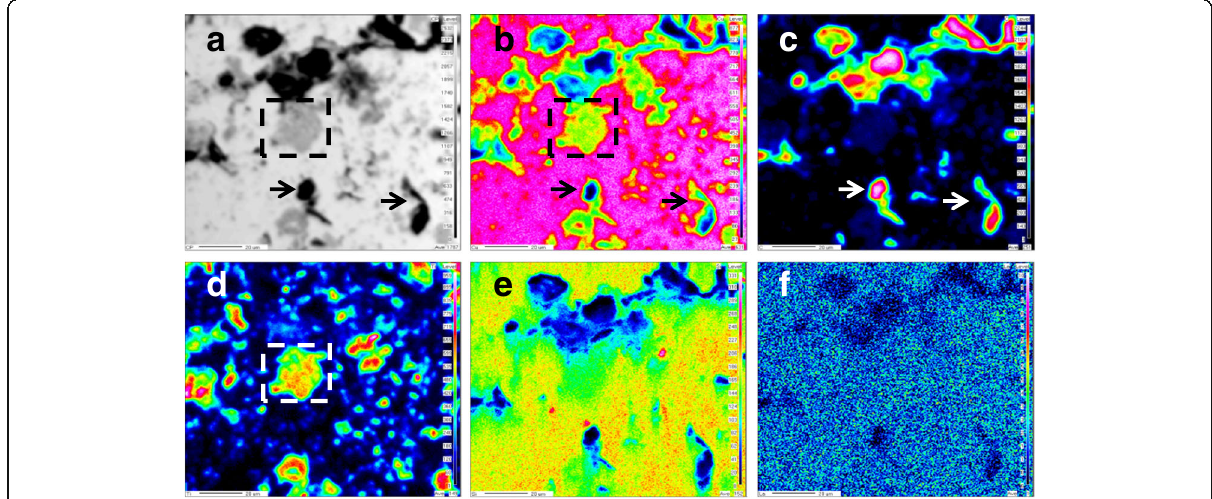
Fig. 4 EPMA analyses of sintered nanocomposites with 0.2 wt% graphenes and 0.8 wt% MWCNTs. a BS image, b Cu map, c C map, d Ti map, e Si map, and f La